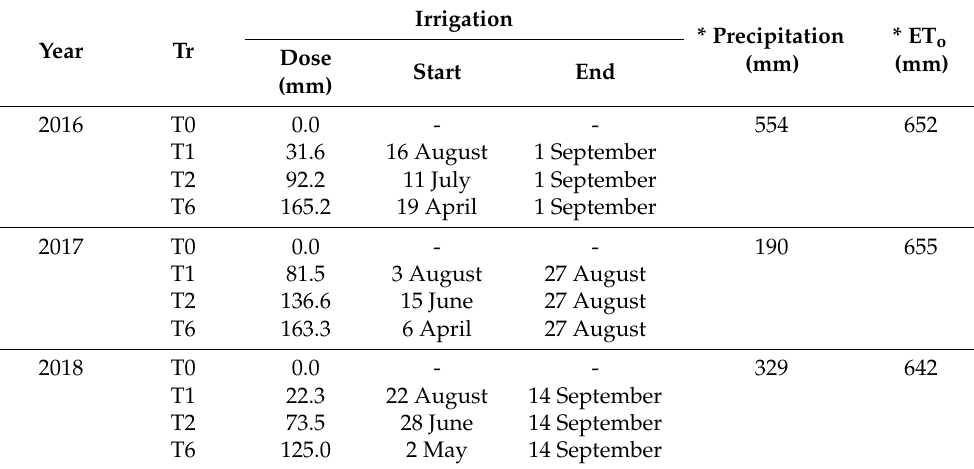
Table 1. Growing season reference evapotranspiration (ET o , mm), precipitation, and doses (mm), as well as key irrigation